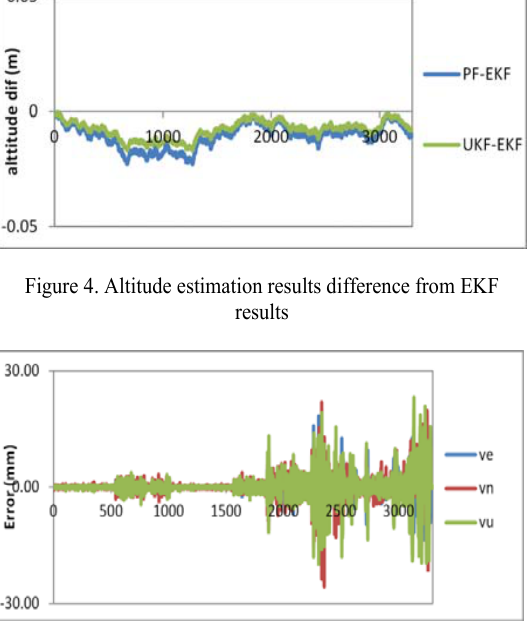
Figure 5. Velocity estimation results accuracy referenced to differential GPS/MEMS-based IMU velocity results